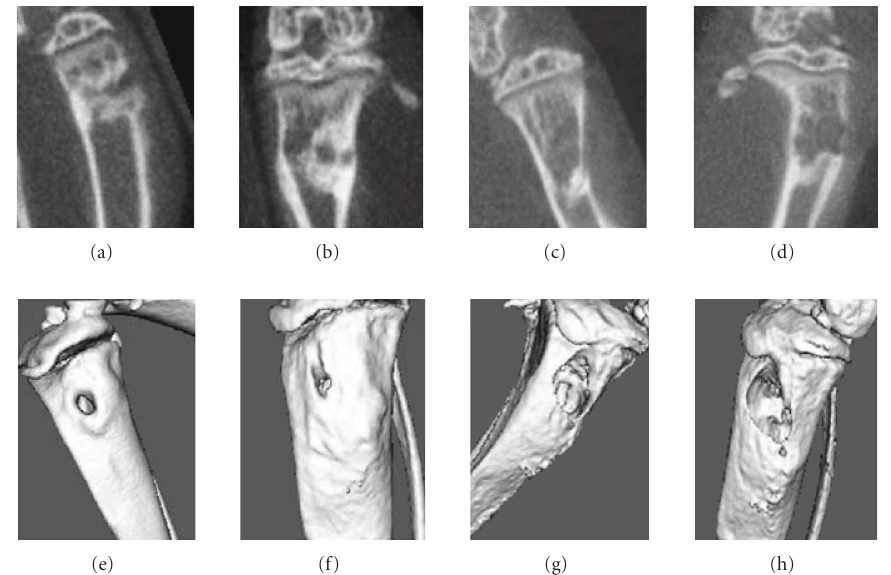
Figure 2: MicroCT images of the orthotopic osteosarcoma model. Panels (a) and (e) shows 7 days after G292 tumor cells inoculation; (b) and (f) show 2 weeks; Panels (c) and (g) show 4 weeks; and panels (d) and (h) show 8 weeks after the tumor cells transfer. Lower panels show the 3D isosurfaces of the tibia harboring